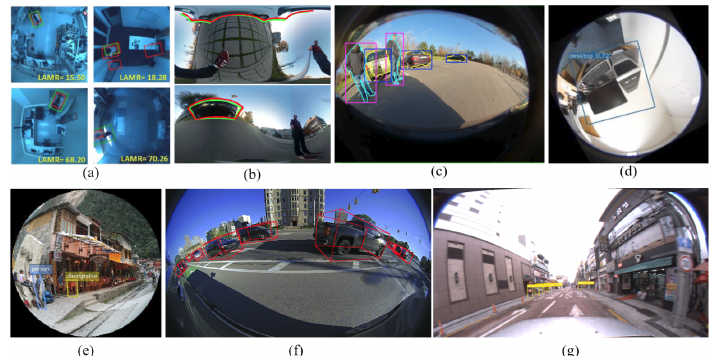
Figure 1. Comparison of the size of bounding boxes: ( a ) Demirkus et al. [8]; ( b ) Coors et al. [9]; ( c ) Arsenali et al. [10]; ( d ) Chen et al. [11]; ( e ) Tangwei et al. [12]; ( f ) Elad et al. [16]; and ( g ) proposed Fisheye-Dongseongro